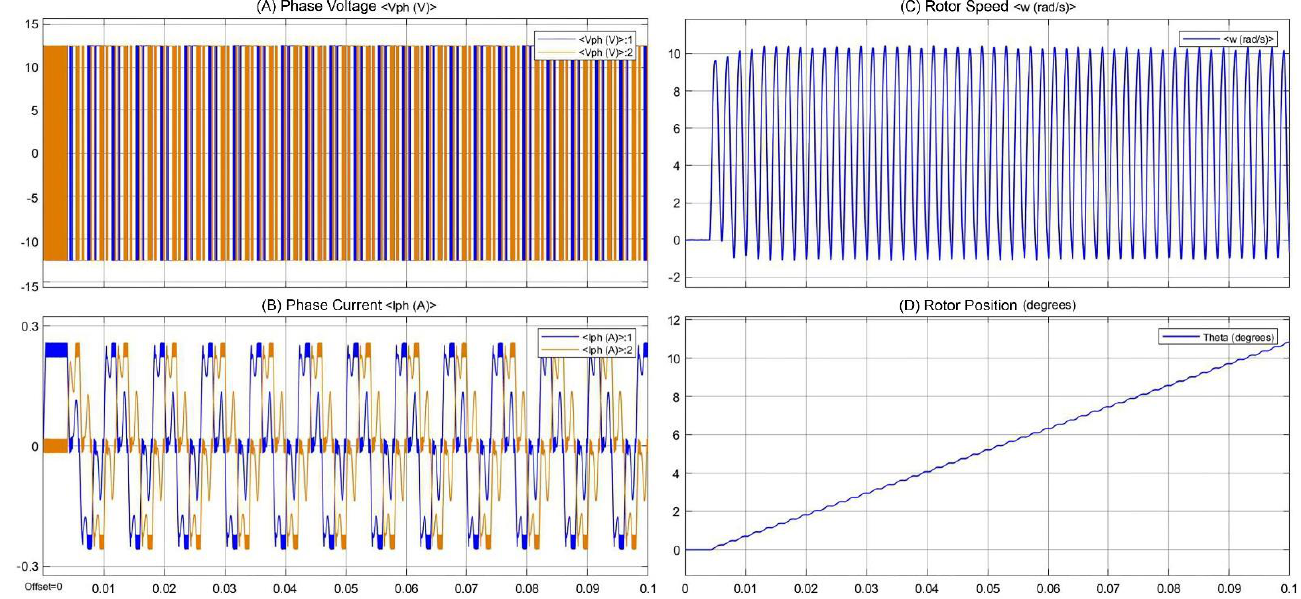
Figure 10. Simulation results of the modeled control system and stepper motor: ( A ) phase voltage; ( B ) phase current; ( C ) rotor speed; ( D ) rotor position.